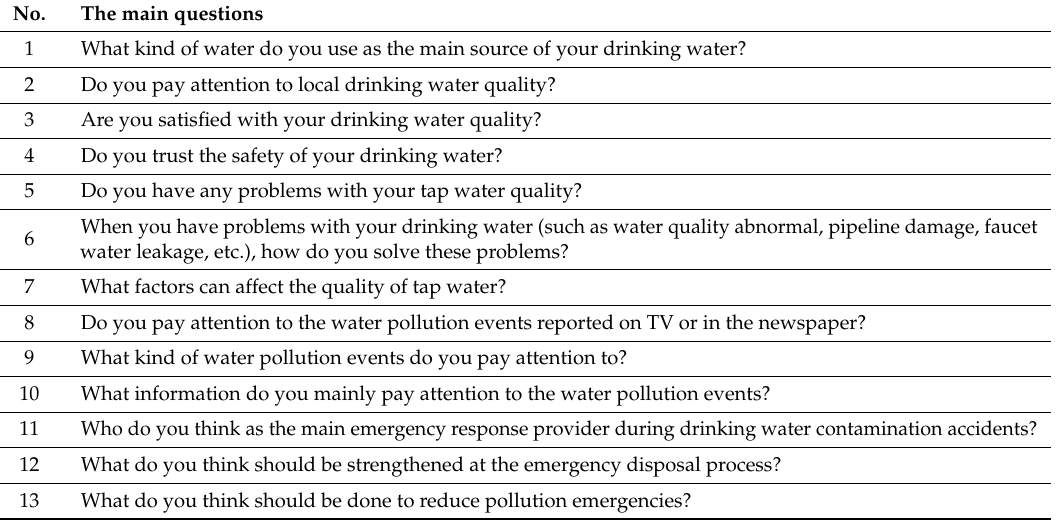
Table 1. The main questions of the questionnaire.